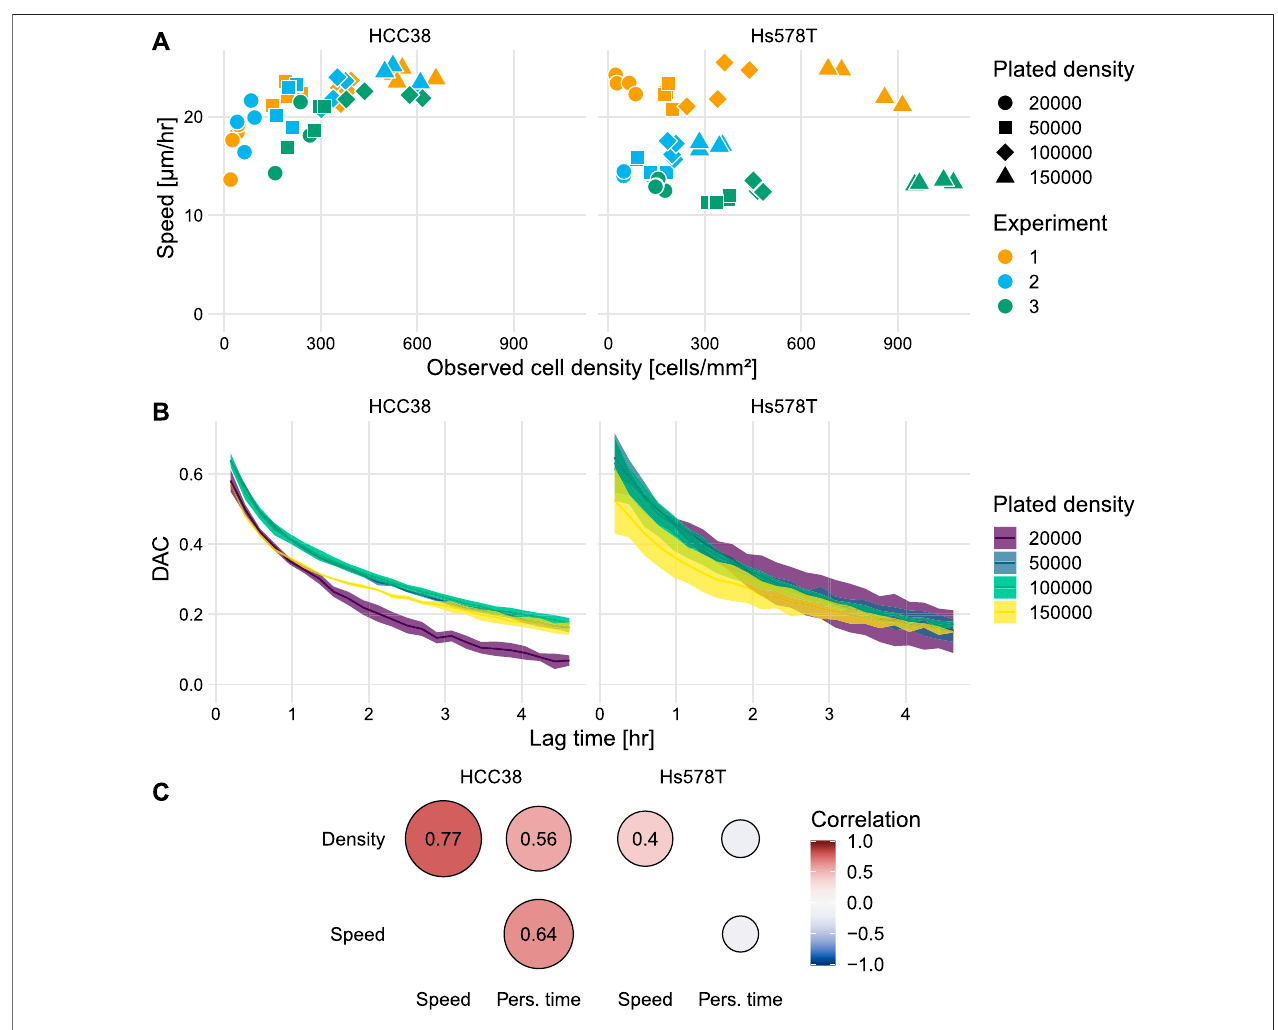
FIGURE 3 | Analysis of the effect of cell density on cell speed and persistence. (A) Instantaneous speed for all individual wells as a function of the observed cell density within wells. Colors indicate results for the three separate experiments. (B) Mean ± SEM of the DAC as a function of the elapsed time for individual tracks. Note thatthedataforHs578Tfromexperiment2wasexcludedfromthisanalysisbecausethedifferencesindensitywereverysmall[see (A) and SupplementaryFigureS4 ]. (C) Correlogram showing the correlations between the observed cell density, instantaneous speed, and persistence time.